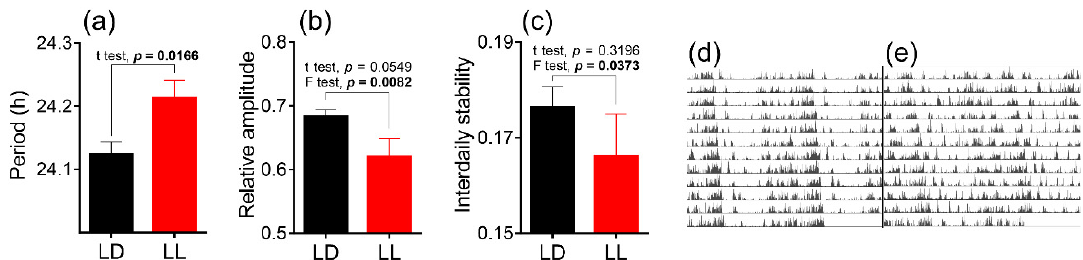
Figure 1. E ff ect of development under constant light (LL, in red; controls in light / dark (LD) in black) on ( a ) the circadian period, ( b ) relative amplitude, and ( c ) interdaily stability of the rhythm in the locomotor activity of male rats. Animals were housed under LL (16 lux) from the postnatal day 0 (P0) until P20 and then released into LD conditions. At P60, the animals were released into constant darkness (DD) and circadian parameters were calculated from 12 days of locomotor recordings. Each column represents the mean of 11 values ± SEM. p = ; two-tailed Student’s t -test and F test comparing variances between groups; ( d , e ) representative actograms of a control animal and LL-exposed animal, respectively.